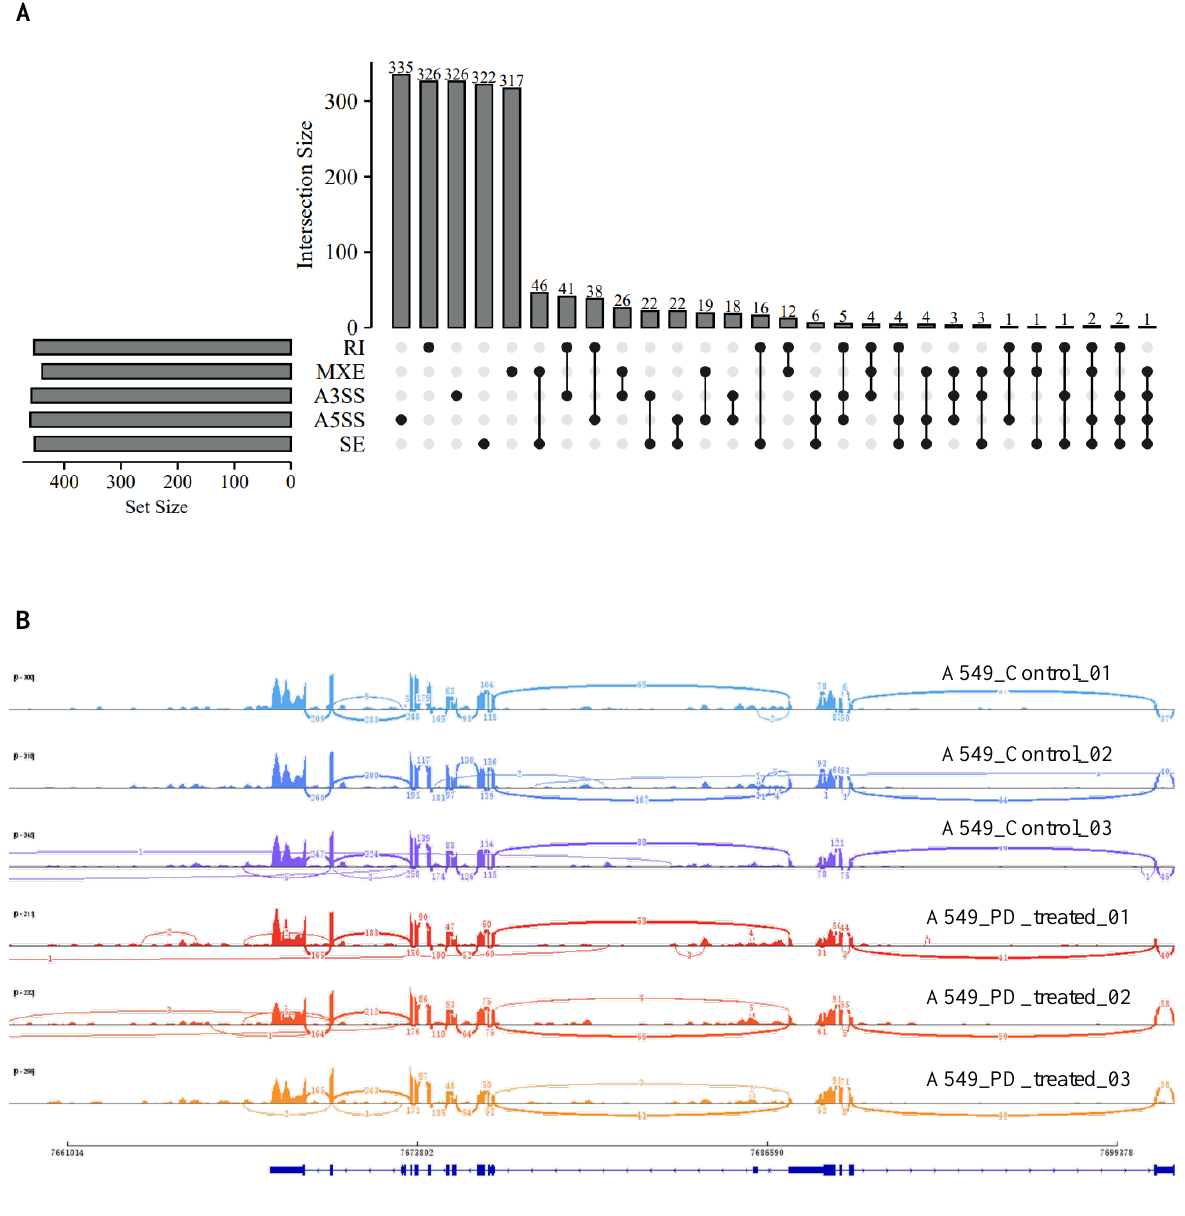
Figure 6. Analysis of alternative splicing events in DE-mRNAs between the PD-treated A549 cells and the control. ( A ) An UpSet diagram exhibits five types of alternative splicing events for DE-mRNAs. ( B ) Sashimi plots for the alternatively spliced BCL2 gene in the two